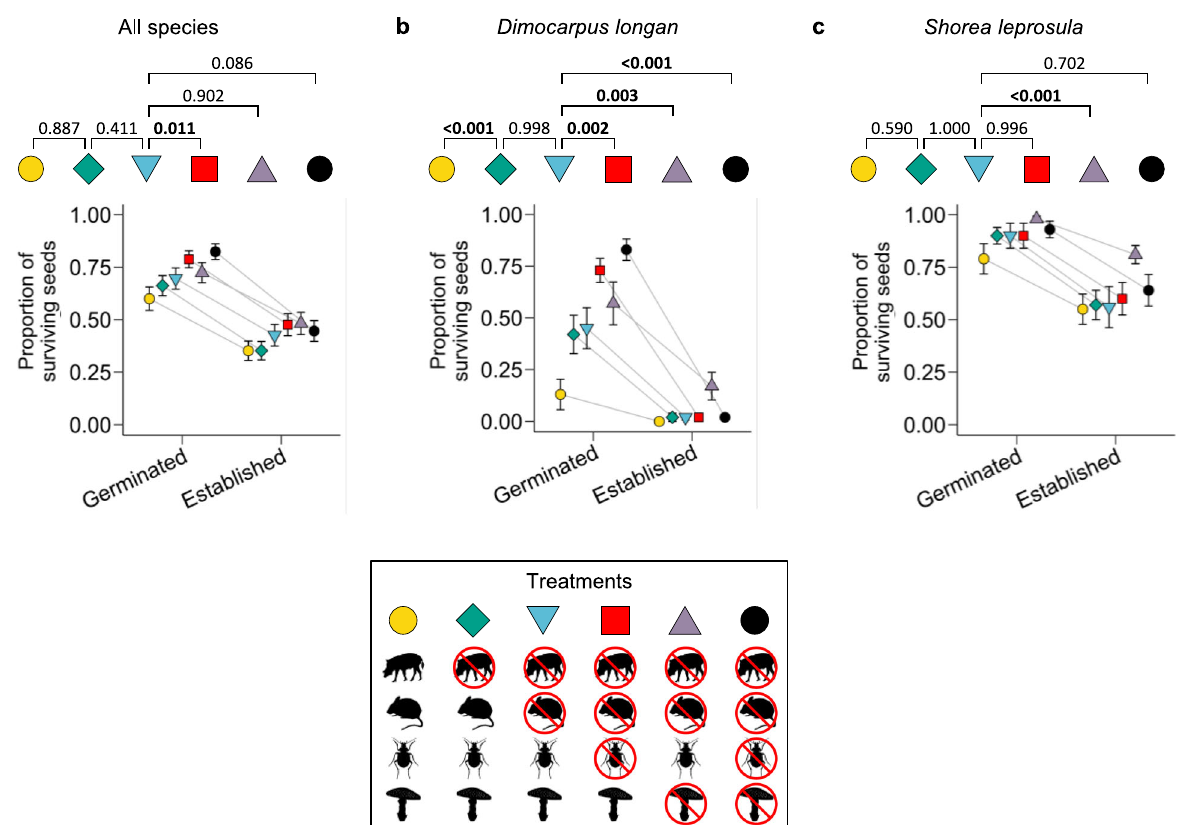
Fig. 5 Seed survival. Proportions of seeds surviving under experimental treatments (indicated by different colors and shapes); error bars indicate mean values ± standard errors across treatments ( N = 50 for all species; N = 10 for individual species). Logistic regressions were performed to test the effect of treatment on seed survival. Then, post-hoc Tukey tests were used to adjust for multiple tests and identify signi fi cant pairwise comparisons. All statistical tests were two-tailed. Selected pairwise comparisons shown with P-values; signi fi cant comparisons in bold. a Across species, insecticide increased survival ( P = 0.011). b , c Fungicide increased survival in Dimocarpus longan ( P = 0.003) and Shorea leprosula ( P <